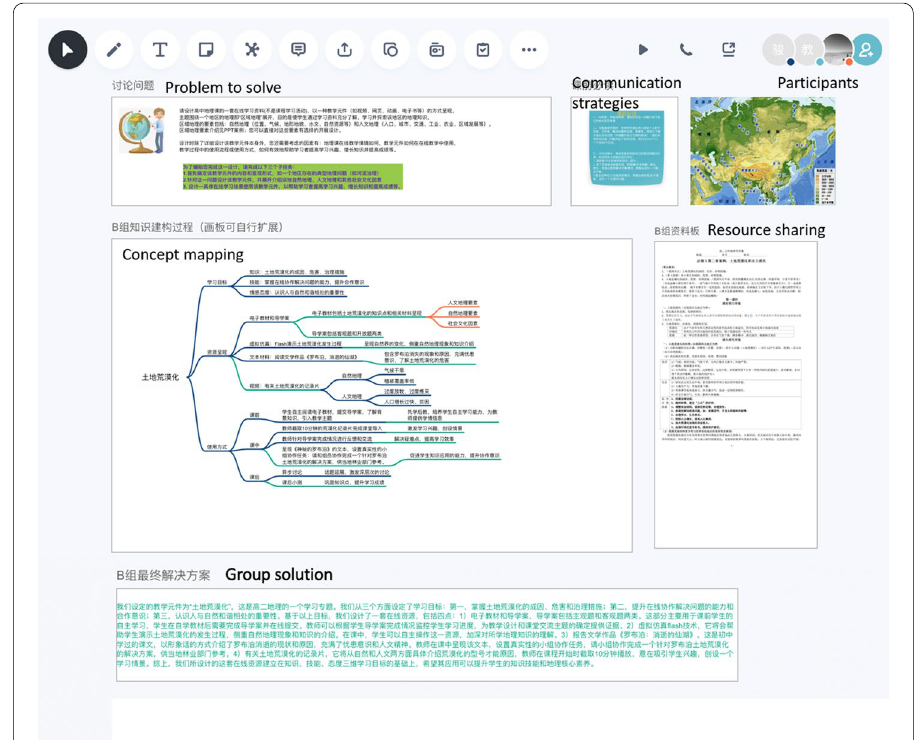
Fig. 2 A group’s screenshot on the Huiyizhuo